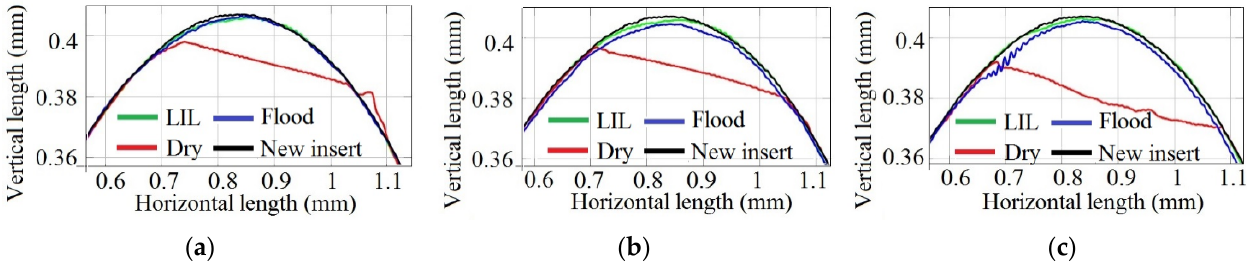
Figure 12. Profiles of a section of the cutting insert tip under different lubrication conditions for ( a ) 1000 m, ( b ) 2000 m and ( c ) 3000 m of sliding distance tests.